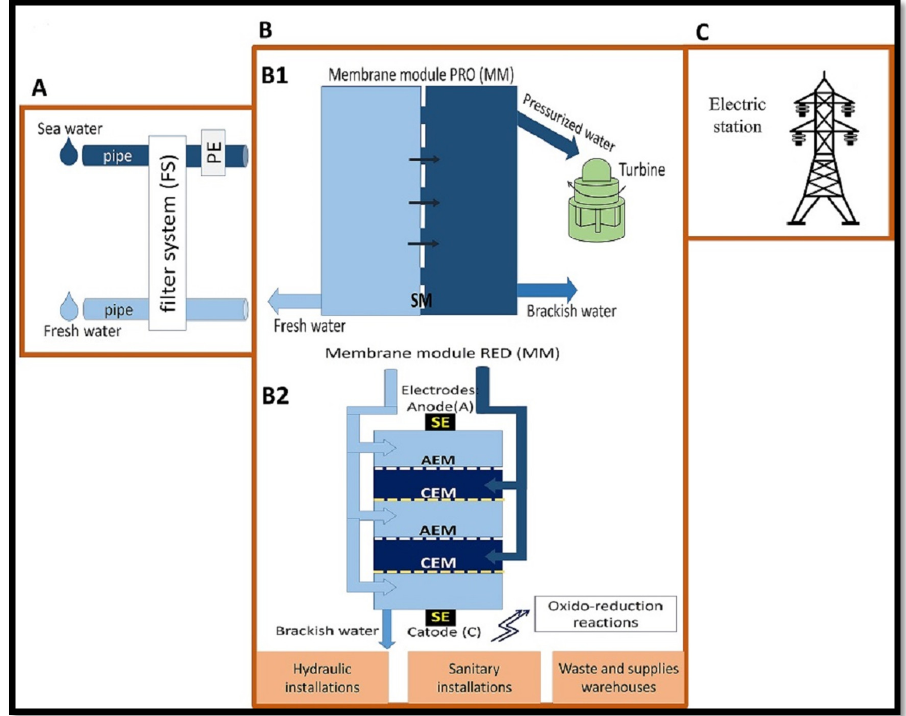
Figure 2. Components and processes involved in RED and PRO technologies that may produce environmental impacts in coastal systems. Abbreviations: PE (pressure exchanger), SE (electrolyte solution), AEM (anion exchange membrane), CEM (cation exchange membrane). The components by sections are shown (A, B and C).